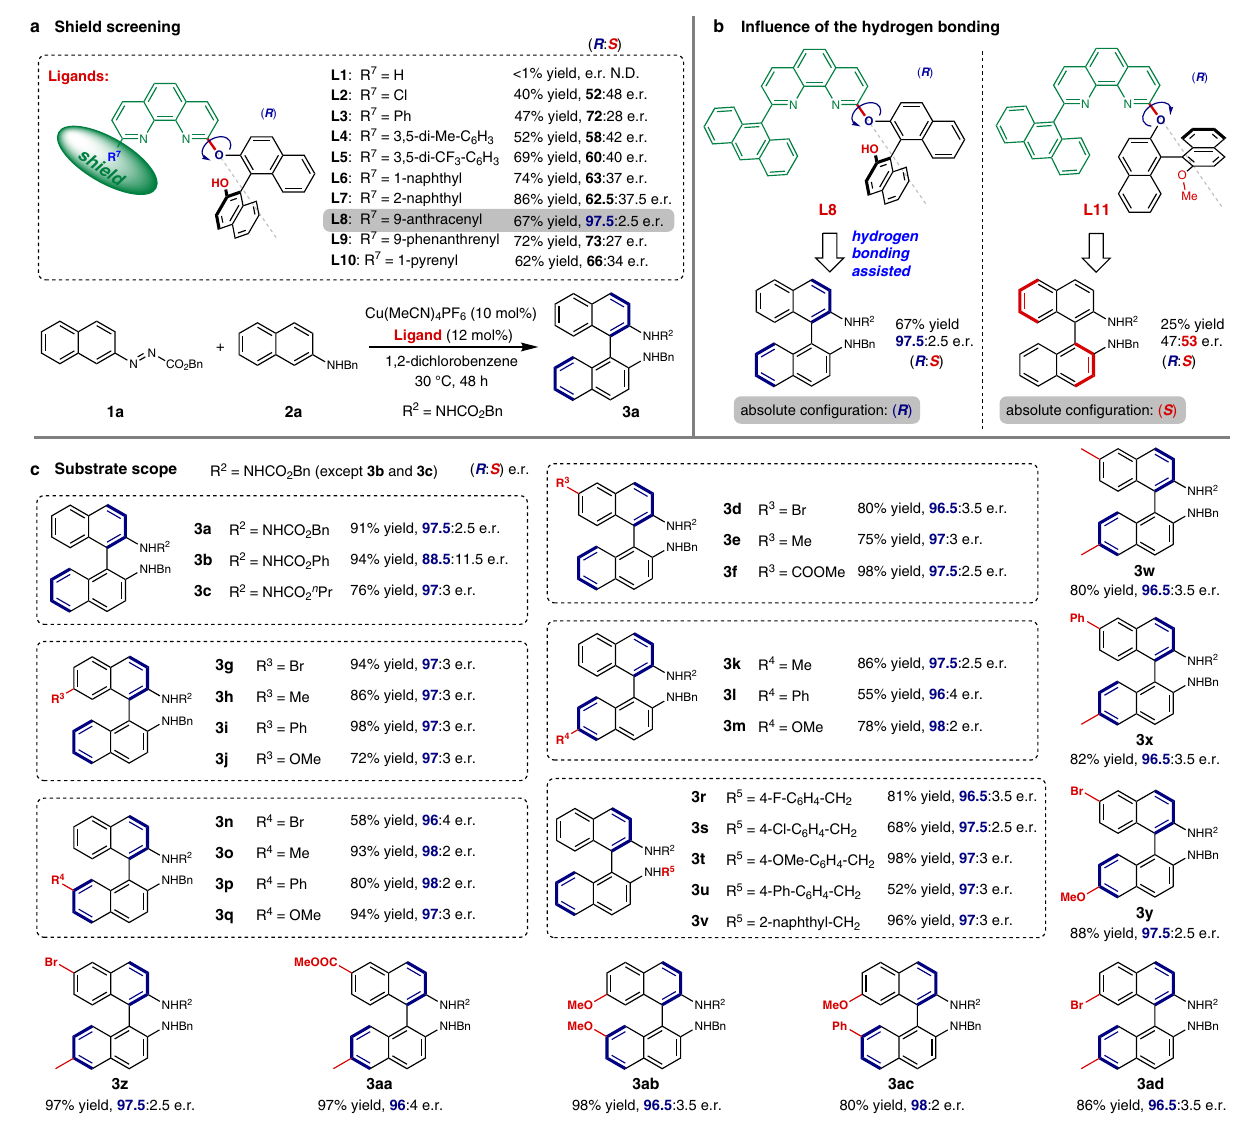
Fig. 2 | Conformational enantiodiscrimination for the asymmetric cross- coupling of azonaphthalenes with 2-naphthylamines. a Shield screening (48h). b In fl uence of the hydroxy group (48h). c Substrate scope (60h). Reaction con- ditions: 1 (0.10mmol), 2 (0.12mmol), 1,2-dichlorobenzene (2.0mL), under air,